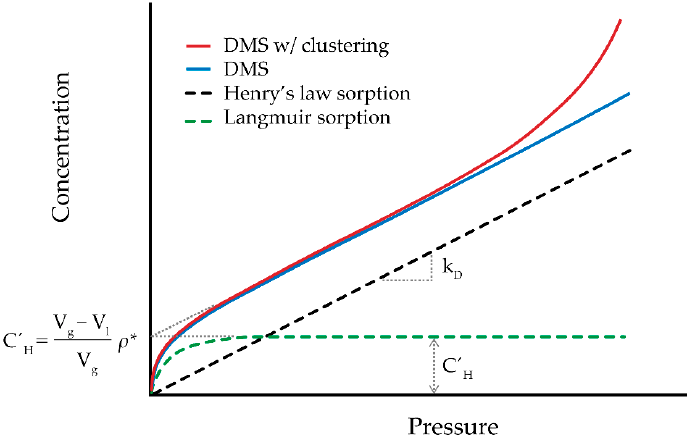
Figure 4. Schematic representation of permeant sorption mechanisms in polymeric structure. Mass density of permeant, denoted by 𝜌 ∗ , is reciprocal value of its partial molar volume (mol/cm 3 ). Reproduced with permission from [123]. H and D represent “holes” and “dissolved”, respectively.